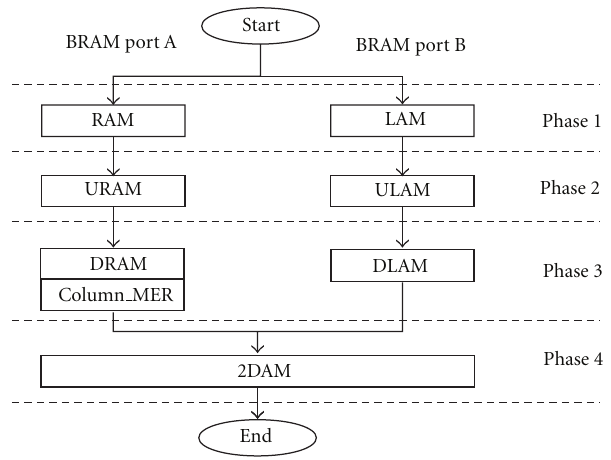
Figure 20: EAD updating process. Table 2: Measured performance figures.